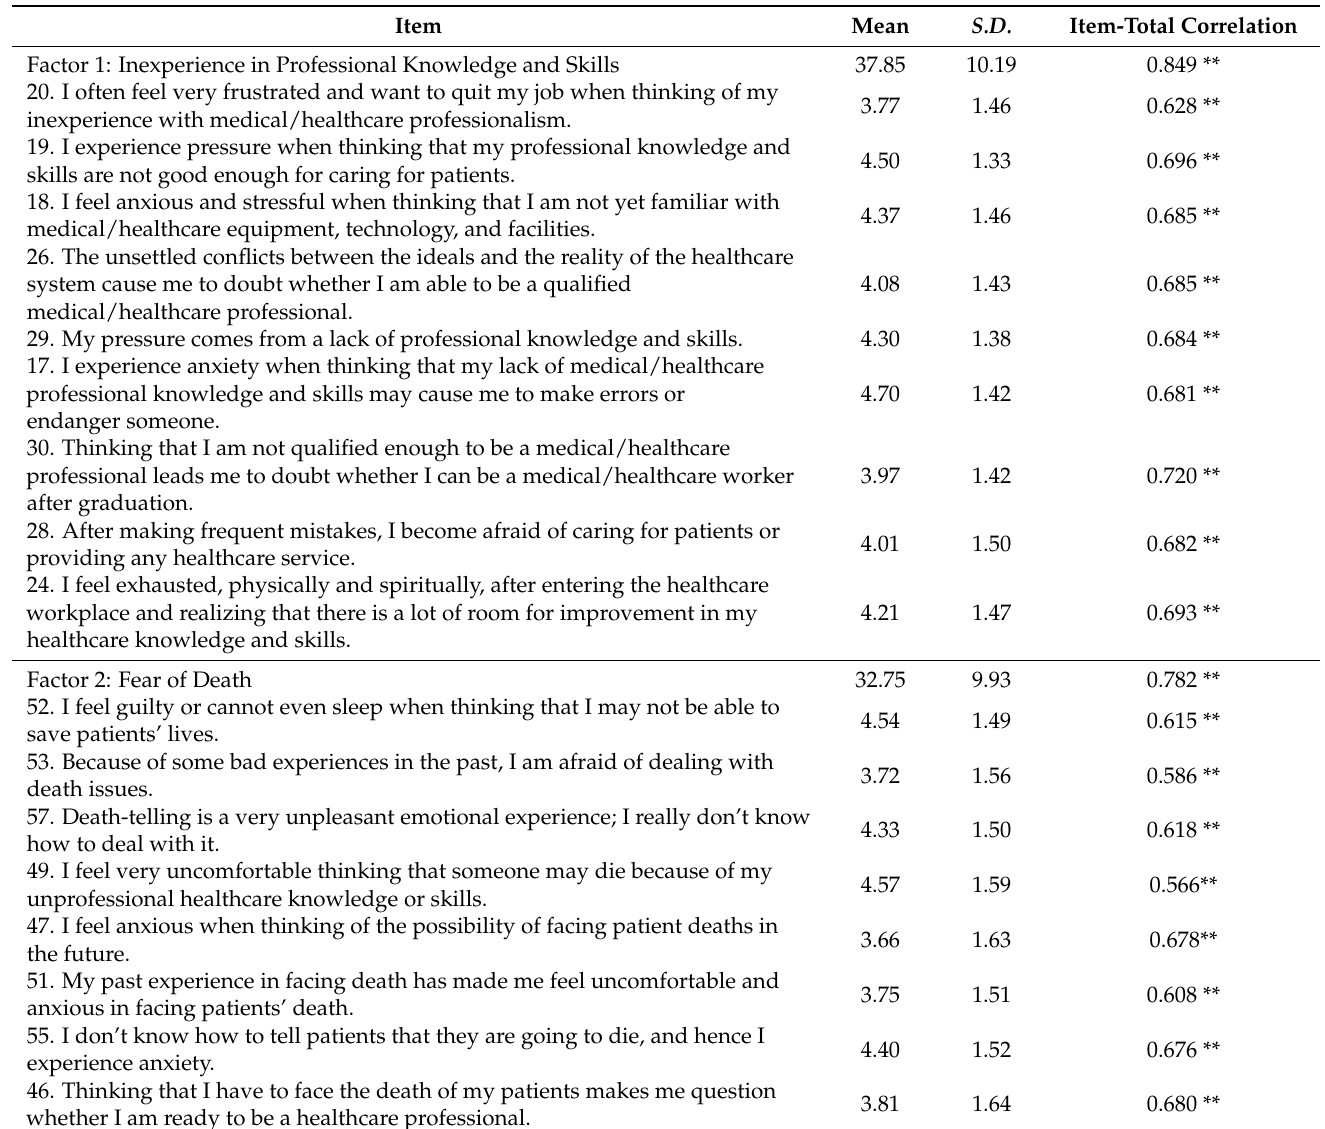
Table 2. Scale item description, average item scores, standard deviations, and item-total correlations of the EFA on the StWTA-HS.